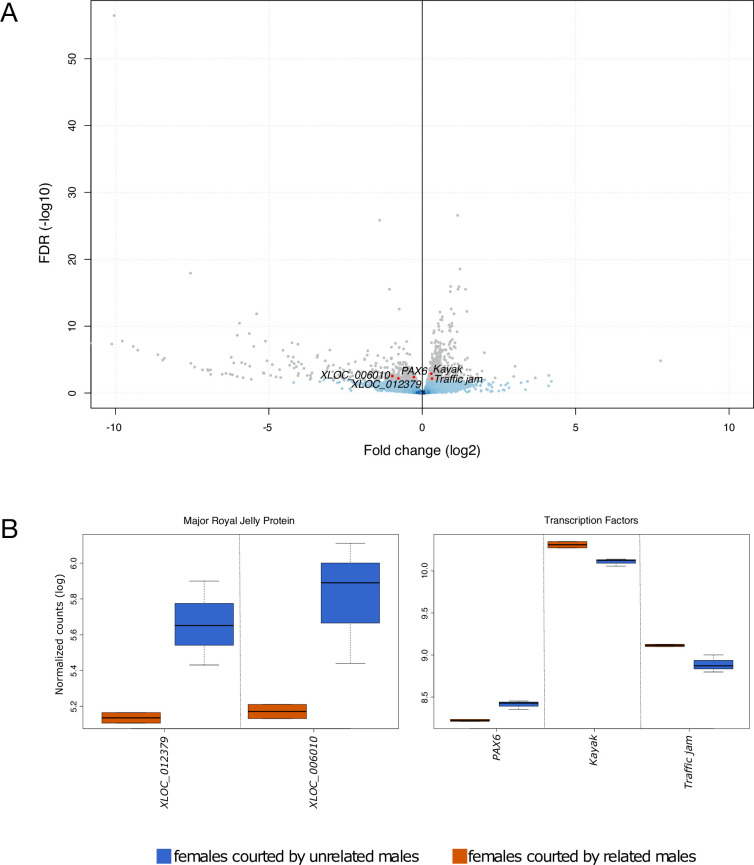
Influence of relatedness of courting males on females’ transcriptome expression: 5.9% of the total transcriptome (grey) was regulated according to the relatedness of the courting male.(A) Comparison of females courted by related males to females courted by unrelated males showed 481 genes overexpressed in females courted by related males (positive fold change values) and 350 genes overexpressed in females courted by unrelated males (negative fold change values). (B) Boxplot showing significant expression changes according to the relatedness of the courting male for highlighted genes mentioned in the text. The X axes indicate gene names, Y axes show normalized counts after log transformation, and boxplot whiskers show the range of read counts between biological replicates. Yellow—mrjp: yellow major royal jelly proteins; PAX6: paired box 6.